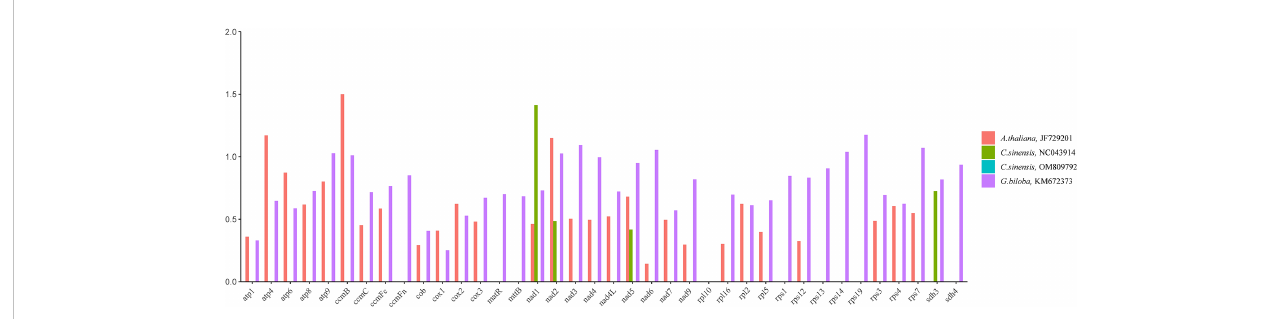
FIGURE 4 Ka/Ks ratios of thirty-eight PCGs in C.duntsa , C.sinensis (NC043914), C.sinensis (OM809792), A.thaliana (JF729201),and G.biloba